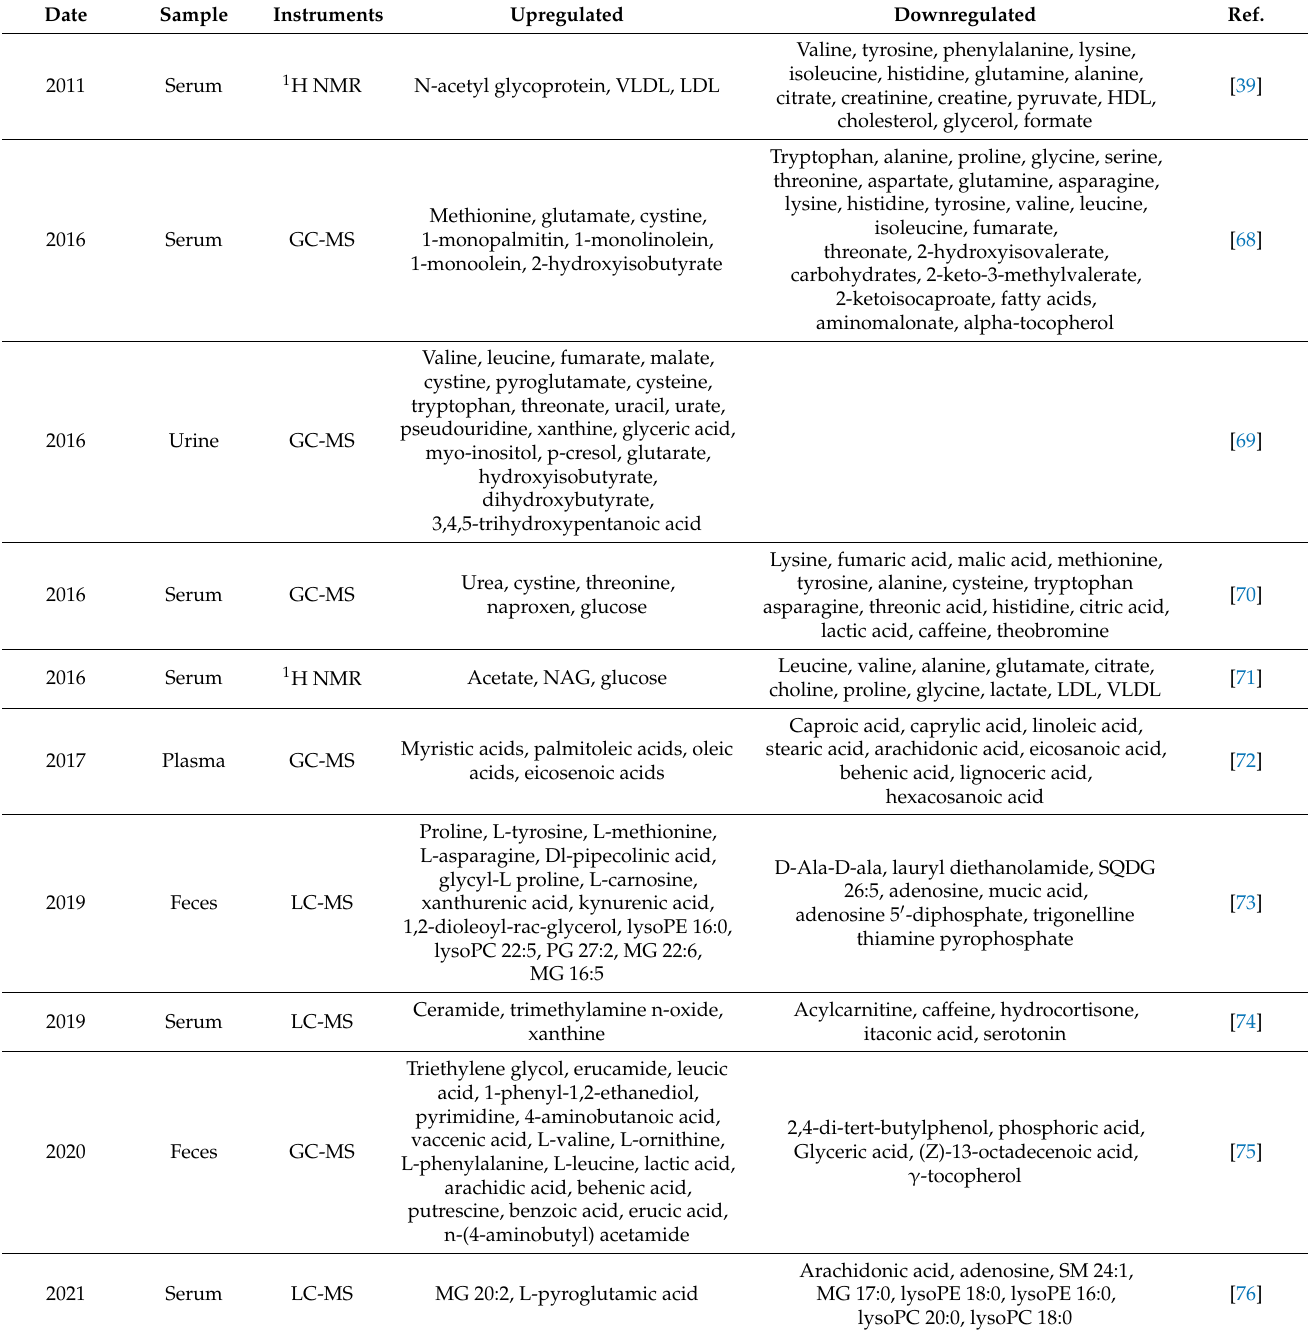
Table 3. Metabolic changes and related studies on patients with systemic lupus erythematosus (SLE).